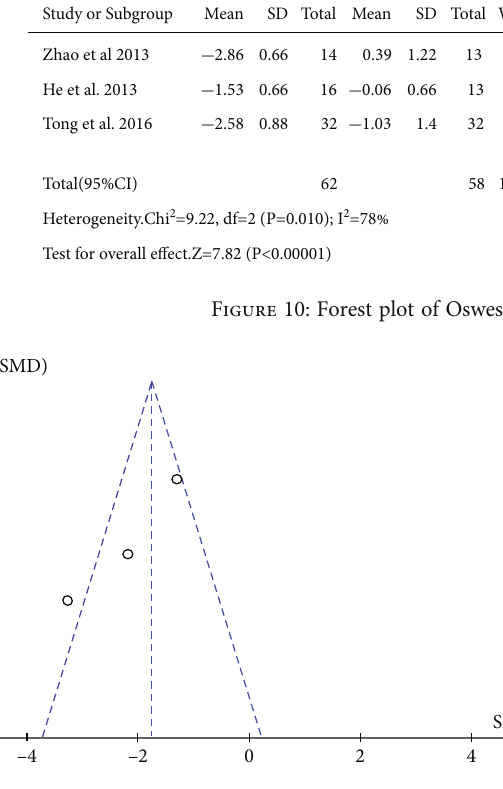
Figure 11: Funnel plot of Oswestry disability index for Tai Chi for